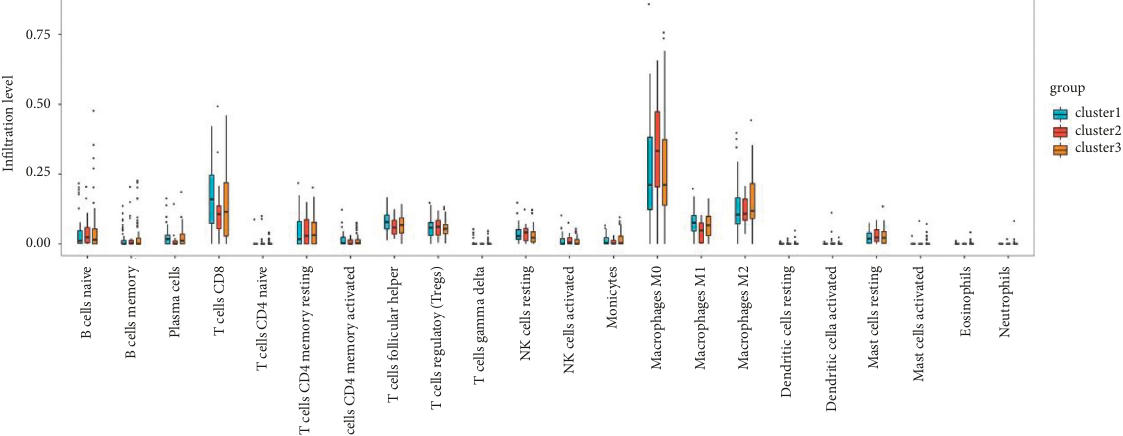
Figure 7: The proportion of 22 subtypes of immune